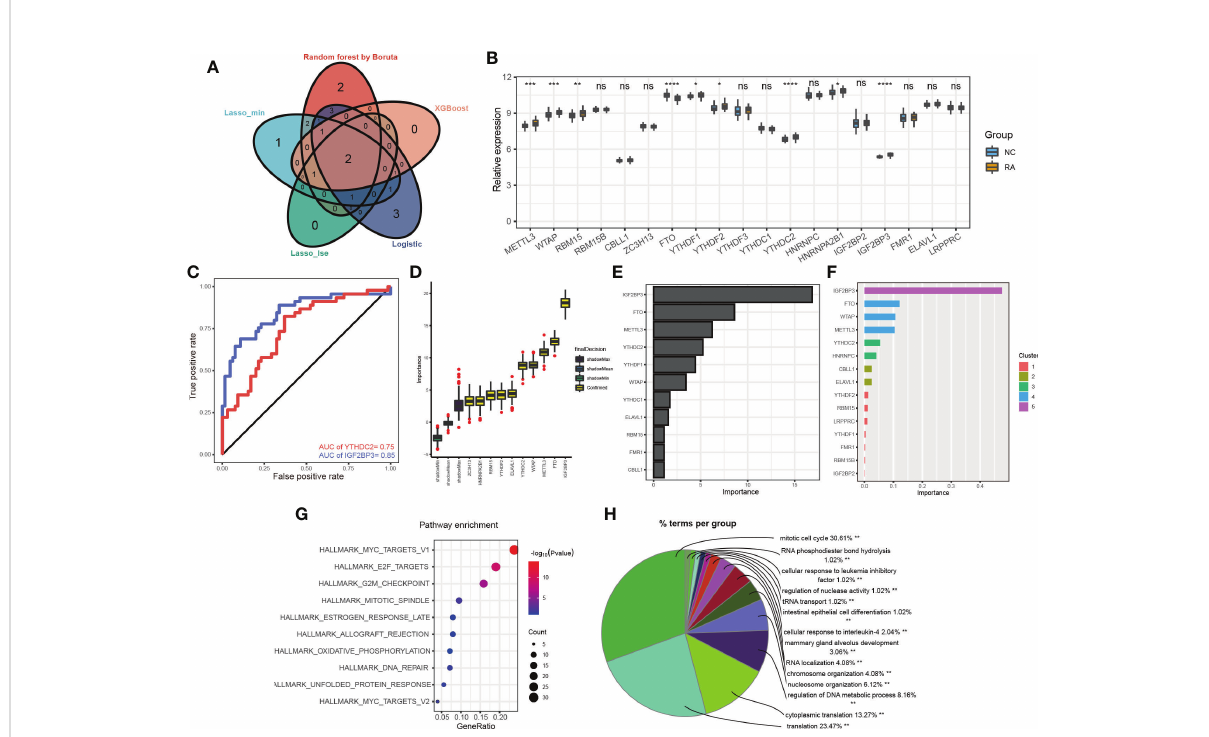
FIGURE 3 The more important m6A methylation regulators in RA classi fi cation. (A) Venn diagram of the m6A methylation regulators selected by the different machine learning methods; (B) the expression levels of 19 m6A methylation regulators in the training dataset; (C) the ROC curves for IGF2BP3 and YTHDC2 in the training set; the importance of the 19 m6a methylation regulators calculated by the Boruta (D) , Rpart (E) and XGBoost (F) algorithms; KEGG pathway (G) and BP (H) enrichment analyses of the gene targets of IGF2BP3 and YTHDC2 *p < 0.05, **p <